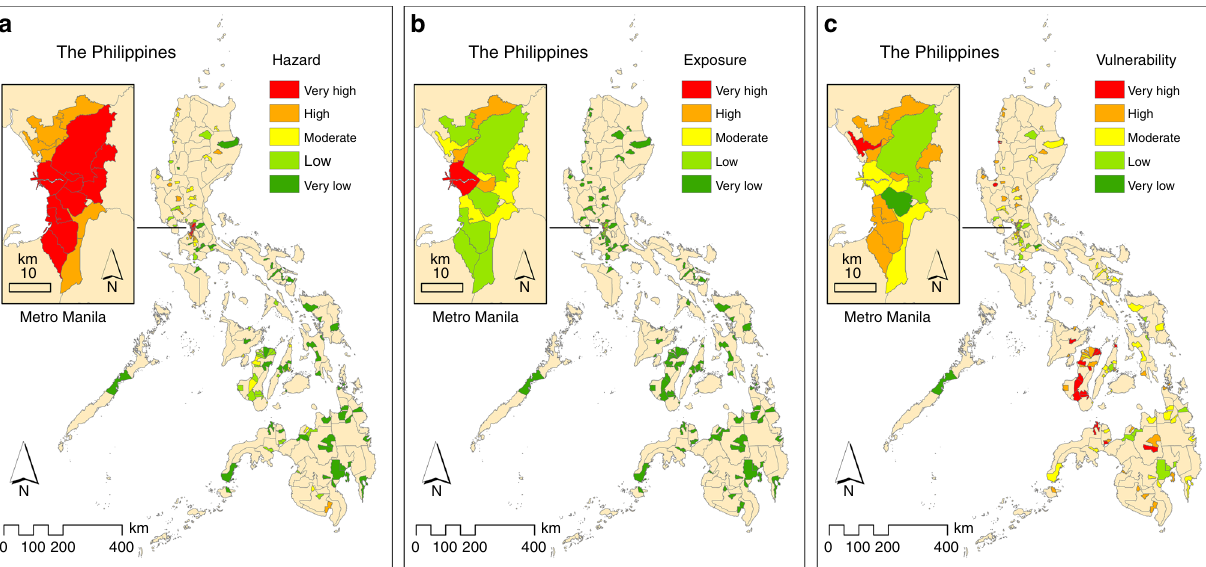
Fig. 3 Spatial distribution of Philippine cities, with their current levels of heat hazard, exposure, and vulnerability (c. 2015). Here, the vulnerability map represents the average of the 12 vulnerability assessments (see Methods). For hazard ( a ), the factor considered was heat — remotely sensed land surface temperature was used as an indicator. For exposure ( b ), the factor considered was exposed human population — population density was used as an indicator. For vulnerability ( c ), age structure and socioeconomic status were considered as factors for sensitivity, whereas natural resource and socioeconomic resource were considered as factors for capacity — proportion of young population, proportion of old population, and poverty incidence were used as indicators for sensitivity, wehereas availability of green space, city net income, and per capita net income were used as indicators for capacity. For details, see Supplementary Table